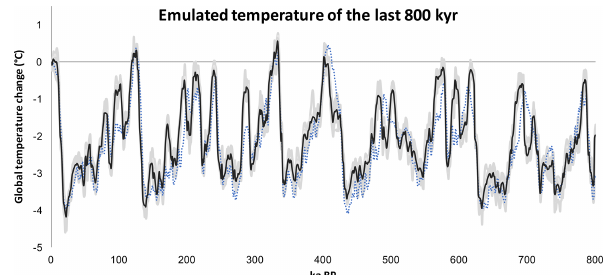
Figure 5. Emulated global temperature over the last 800000 years. An emulator was built 10 times, and the mean prediction time series of each emulator are plotted as grey lines, with the mean of these plotted as the single black line. The blue dotted line is the observa- tionally based reconstruction of Koehler et al. (2010).